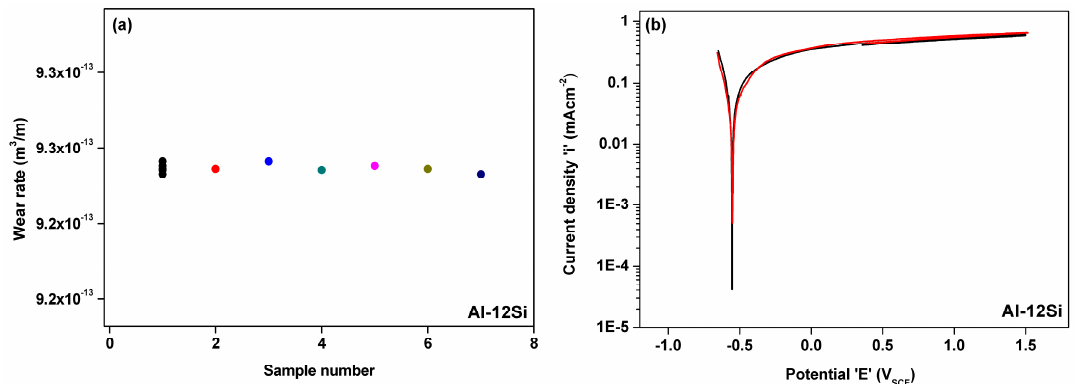
Figure 2. ( a ) Wear rate data for Al-12Si samples carried out at 10 N load; ( b ) Potentiodynamic polarization curves of Al-12Si SLM samples measured in acidic 1 M HNO 3 (pH =